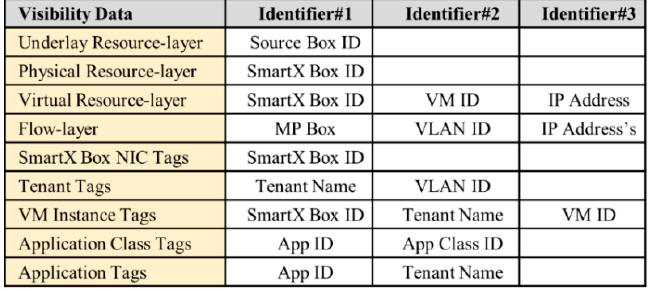
Figure 7. Selected list of key identifiers for visibility data integration.